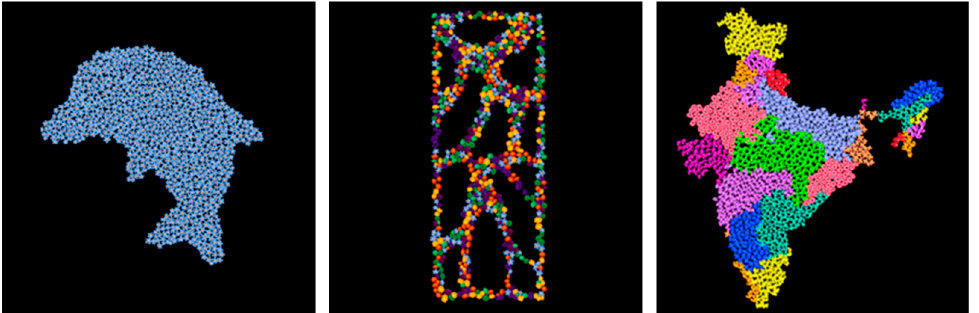
Figure 15. Synthesis results in specified regions.